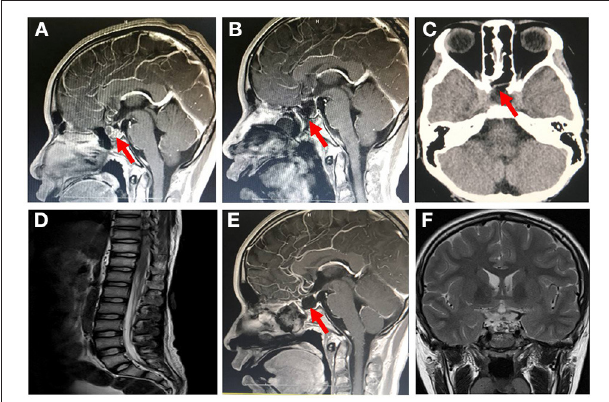
FIGURE 1 | Brain magnetic resonance imaging (MRI) and computed tomography (CT) image after patient admission. (A) Sagittal enhanced MRI of pituitary showed enlarged sella turcica with a mass of about 1.2cm × 1.6cm × 1.4cm in it, pituitary stalk extension to the right side and optic